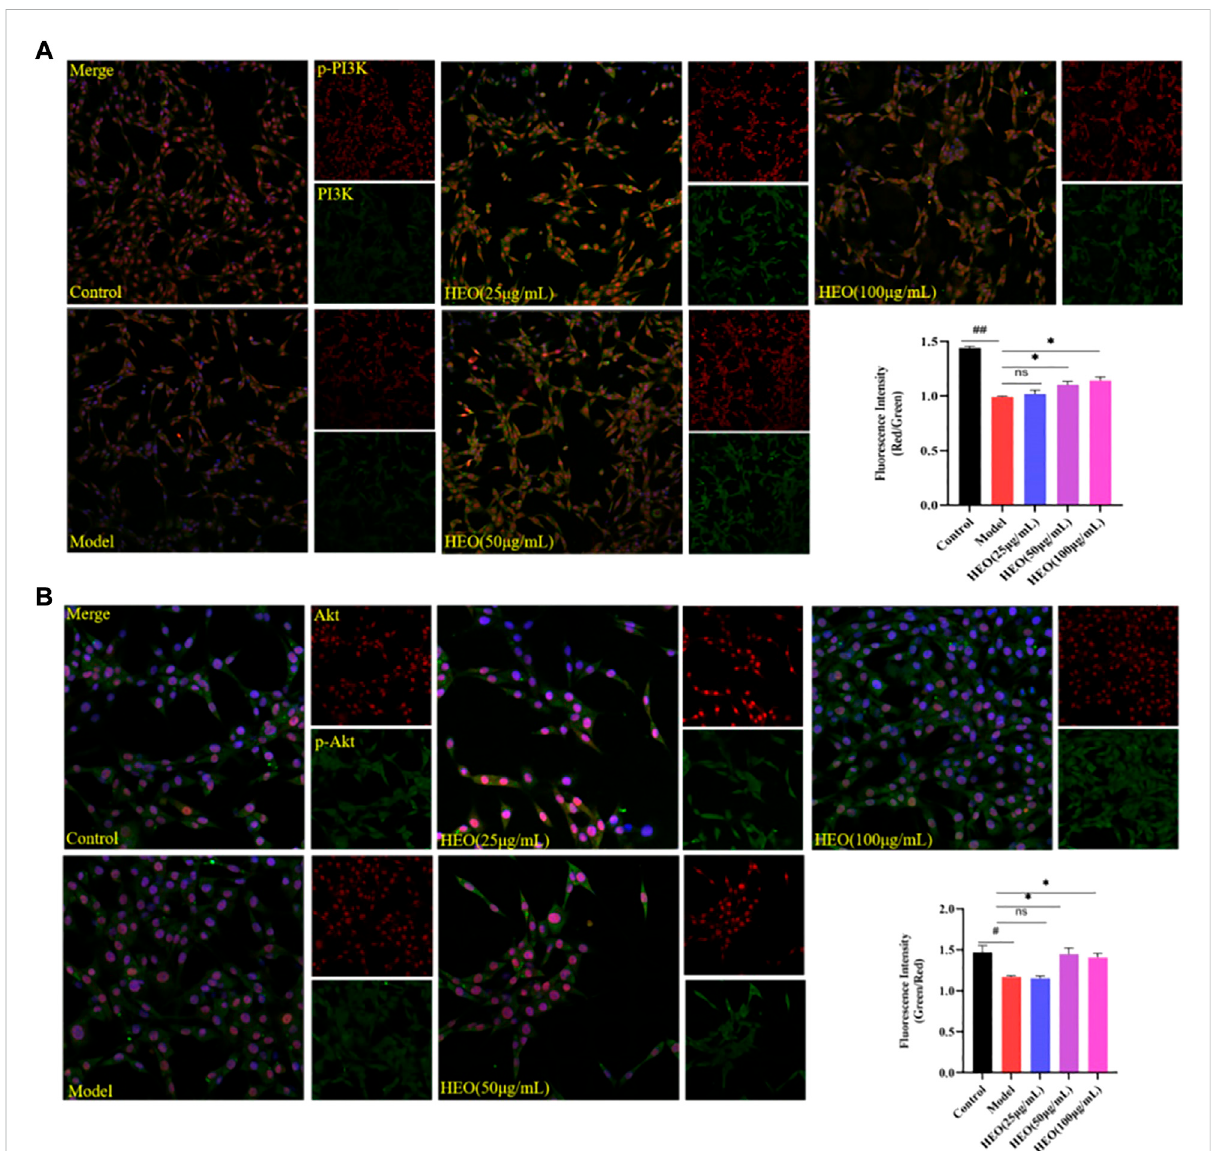
FIGURE 11 Effects ofHEO onproteinexpressionsofPI3K, p-PI3K, Akt, andp-AktinCORT-treatedPC12cells. PC12cells werepretreatedwith HEO(25, 50, and 100 μ g/ml) for 4 h, and subsequently subjected to CORT (500 μ M) for 24h. Protein expressions were determined by immunohistochemistry. p-PI3K(Red)/PI3K(Green) (A) ; p-Akt (Green)/Akt (Red) (B) . The values were represented as the mean ± SEM ( n = 3). ## p < 0.01 and # p < 0.05 vs the control group; * p < 0.05 vs the model